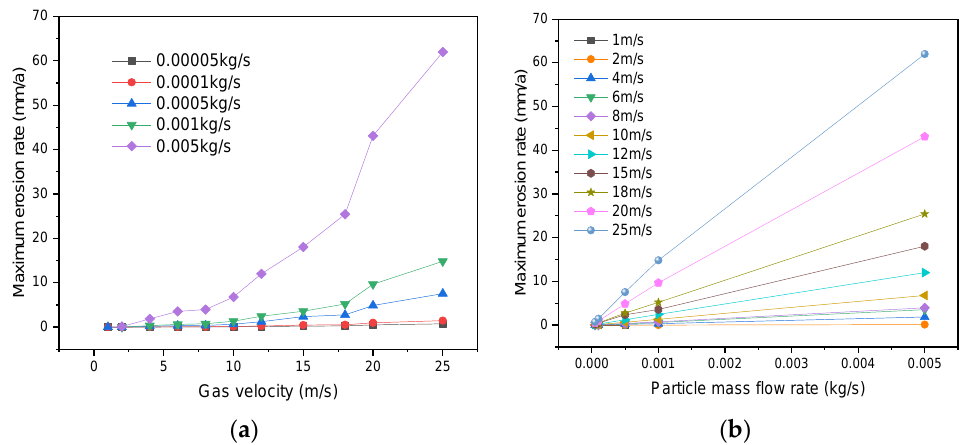
Figure 10. Effect of the gas velocity and particle mass flow rate on the maximum erosion rate. ( a ) Gas velocity; ( b ) Particle mass flow rate.